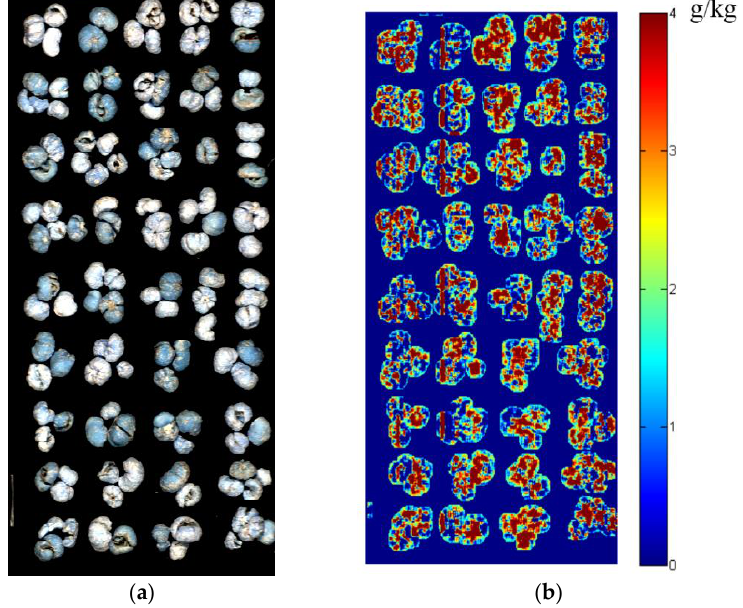
Figure 5. Pseudo-image ( a ) and prediction map ( b ) of a hyperspectral image of the samples fumigated by 10 g sulfur per 500 g